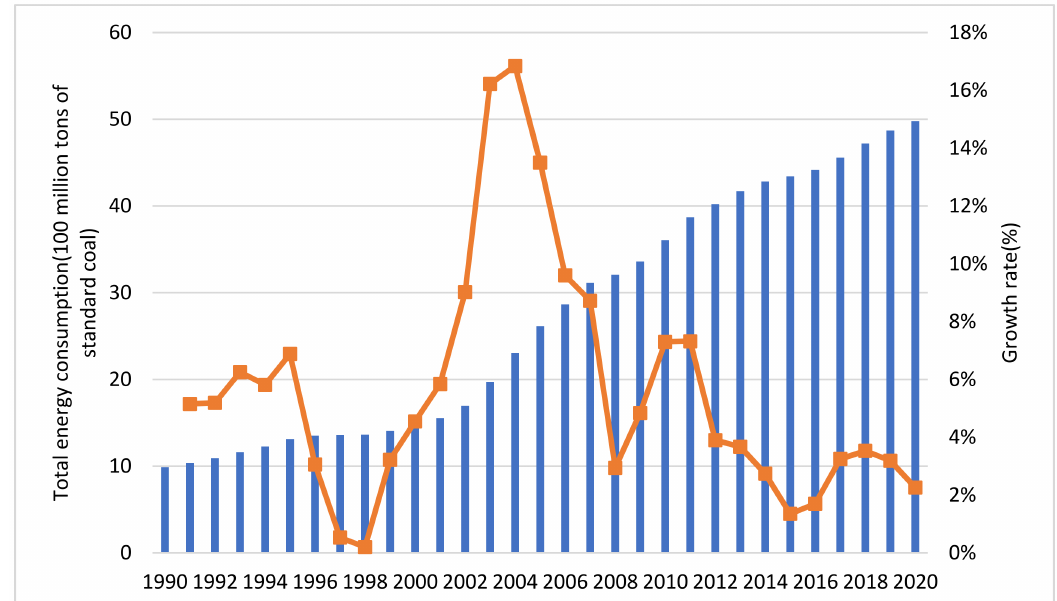
Figure 1. Trends for total energy consumption and growth rate in China. Source: Calculated and compiled based on the China Statistical Yearbook of each year.